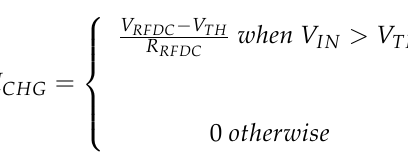
Figure 2. Architecture of the proposed harvesting system (below) compared with the canonical architecture (above).